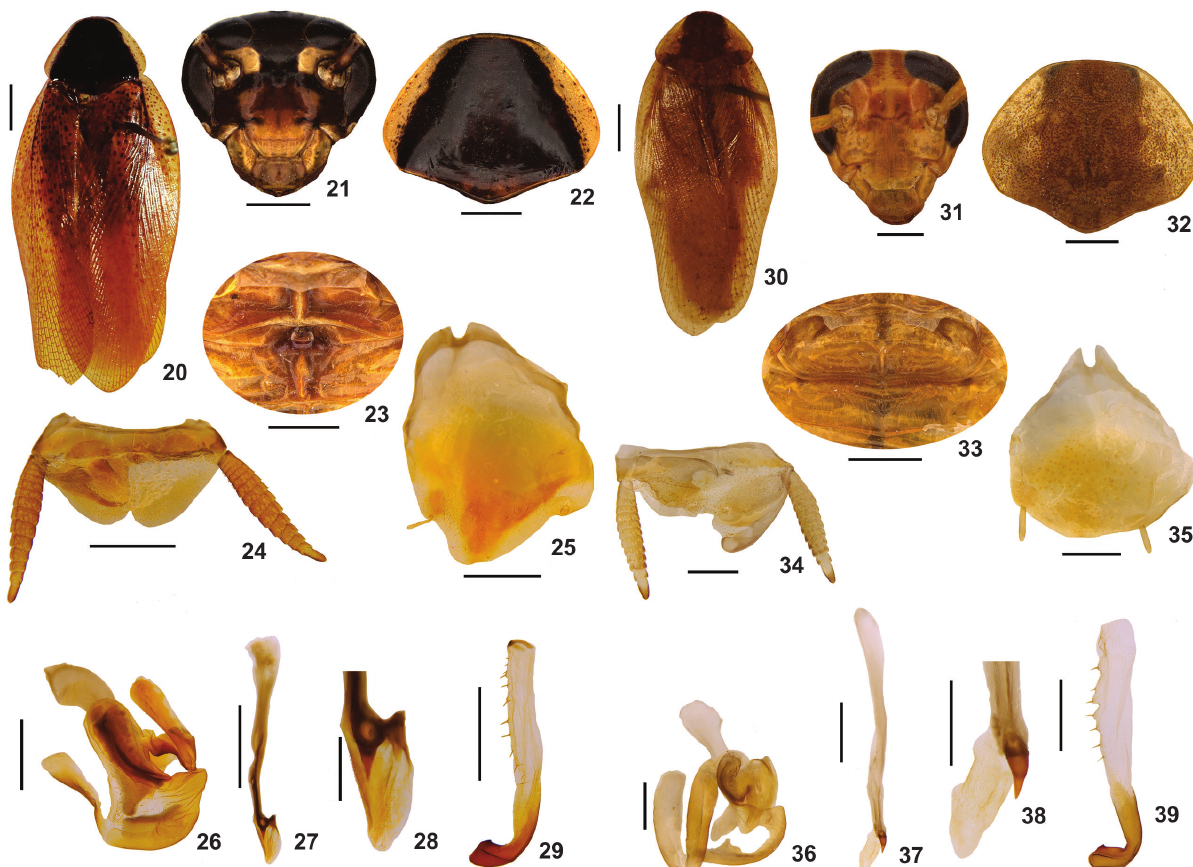
view, (22) pronotum, dorsal view, (23) tergal modification on first and second abdominal segments, dorsal view, (24) supranal plate, dorsal view, (25) subgenital plate, ventral view, (26) left phallomere, dorsal view, (27 and 28) median sclerite, dorsal view, (29) right phallomere, dorsal view. (30–39) Poeciloderrhis diamantinensis sp. nov. holotype male, dorsal view: (30) habitus; (31) Head, ventral view, (32) pronotum, dorsal view, (33) tergal modification of first and second abdominal segments, dorsal view, (34) supranal plate, dorsal view, (35) subgenital plate, ventral view, (36) left phallomere, dorsal view, (37-38) median sclerite, dorsal view, (39) right phallomere, dorsal view. Scale bars: 20 = 5.6 mm; 21 = 1.3 mm; 22 = 2.7 mm; 23-25, 32, 33 = 2.0 mm; 26 = 0.7 mm; 27, 29, 31, 34, 35 = 1.0 mm; 28, 38 = 0.3 mm; 30 = 3.4 mm; 36, 37, 39 = 0.7